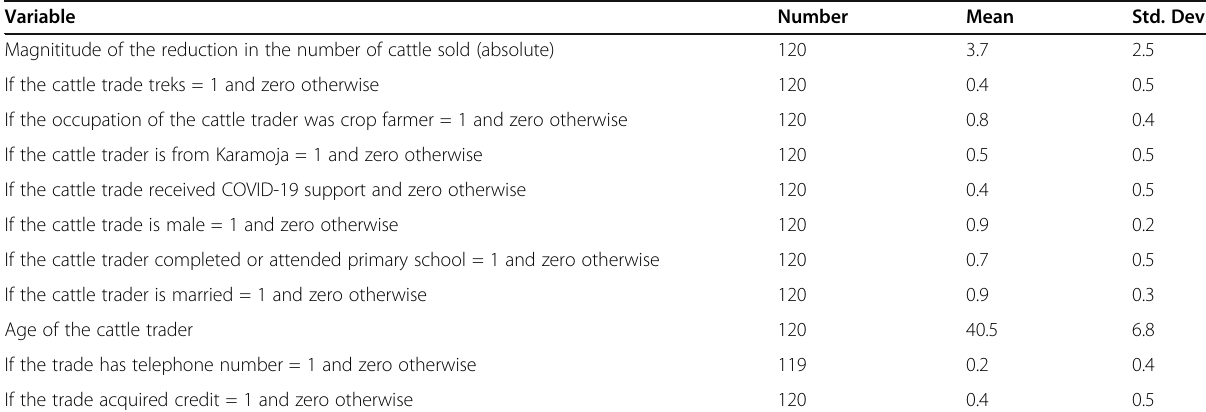
Table 1 Description of the